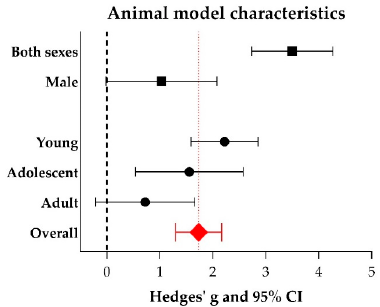
Figure 7. The effect of some animal model characteristics on the ERG b-wave amplitude. For every subgroup, Hedges’ g (a measure for effect size using smaller sample sizes, black solid squares) and its 95% confidence interval (CI) are graphically shown. The left side of the dashed black line (Hedges’ g = 0) favors the control group (untreated or sham-operated) and the right side favors the experimental group (RPE transplantation). An overall beneficial effect of RPE transplantation on the b-wave amplitude was observed (Hedges’ g 1.734 (1.295–2.172), red diamond). Significantly higher b-wave amplitudes were obtained when both sexes were used in the studies as compared to when males only were used (adjusted p-value 0.001). Significantly higher b-wave amplitudes were observed in young animals compared to adult animals (adjusted p-value 0.047).